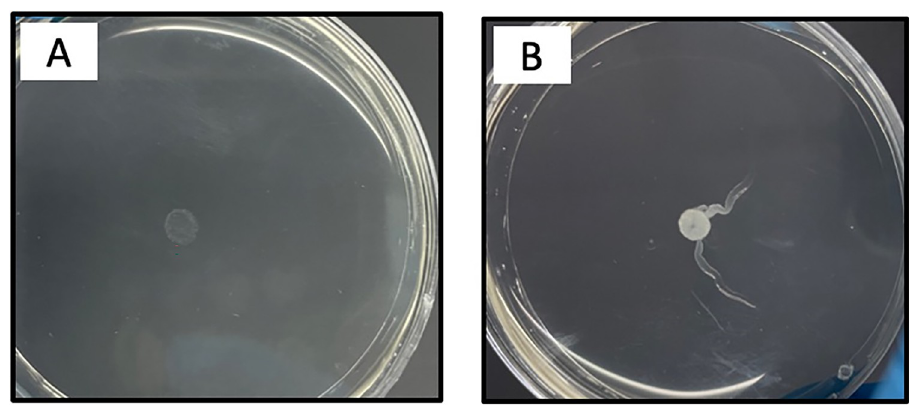
Fig 5. Sliding motility of M . abscessus . (A) Observations on the 8 th day of incubation. (B) Observations on the 16 th day of incubation.